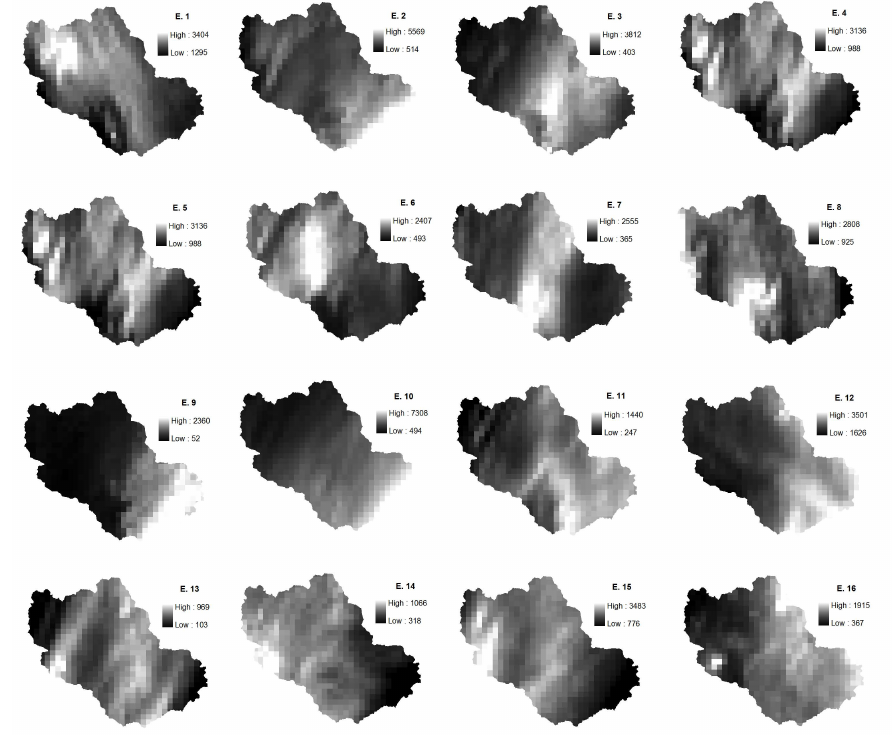
Fig. 3. Radar images of cumulated rainfall for each event (units are in mm ×